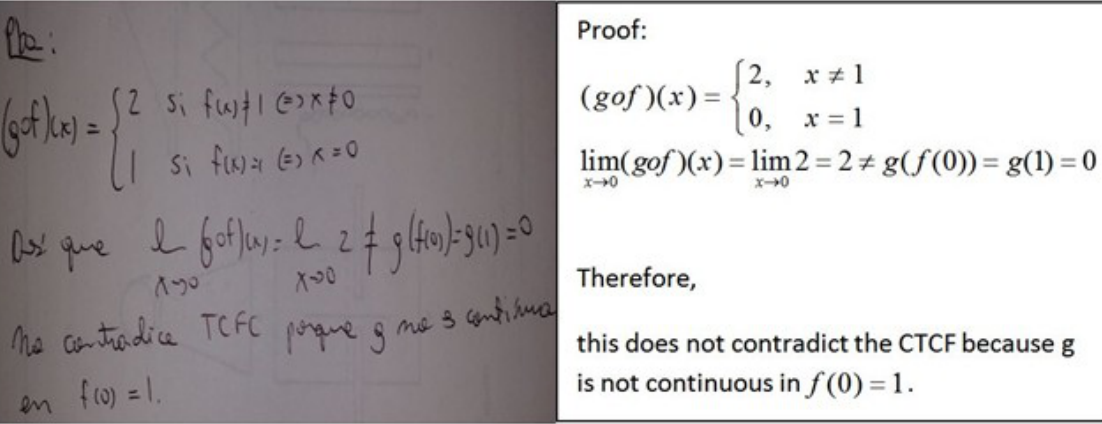
Figure 7. Soluton of the original